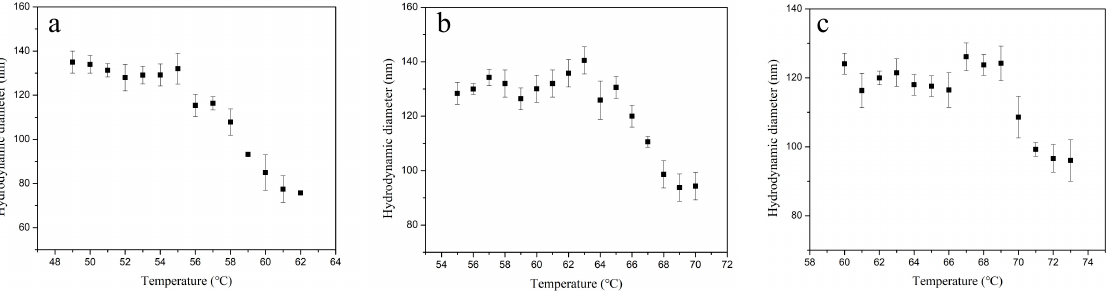
Figure 8. Hydrodynamic diameter of SiO 2 - g -P(OEGMA 30 - stat -AA 70 ) ( a ), SiO 2 - g -P(OEGMA 50 - stat - AA 50 ) ( b ), SiO 2 - g -P(OEGMA 70 - stat -AA 30 ) ( c ) nanoparticles as a function of temperature, these measurements were performed at pH = 11. The error bars correspond to standard deviations from three measurements.